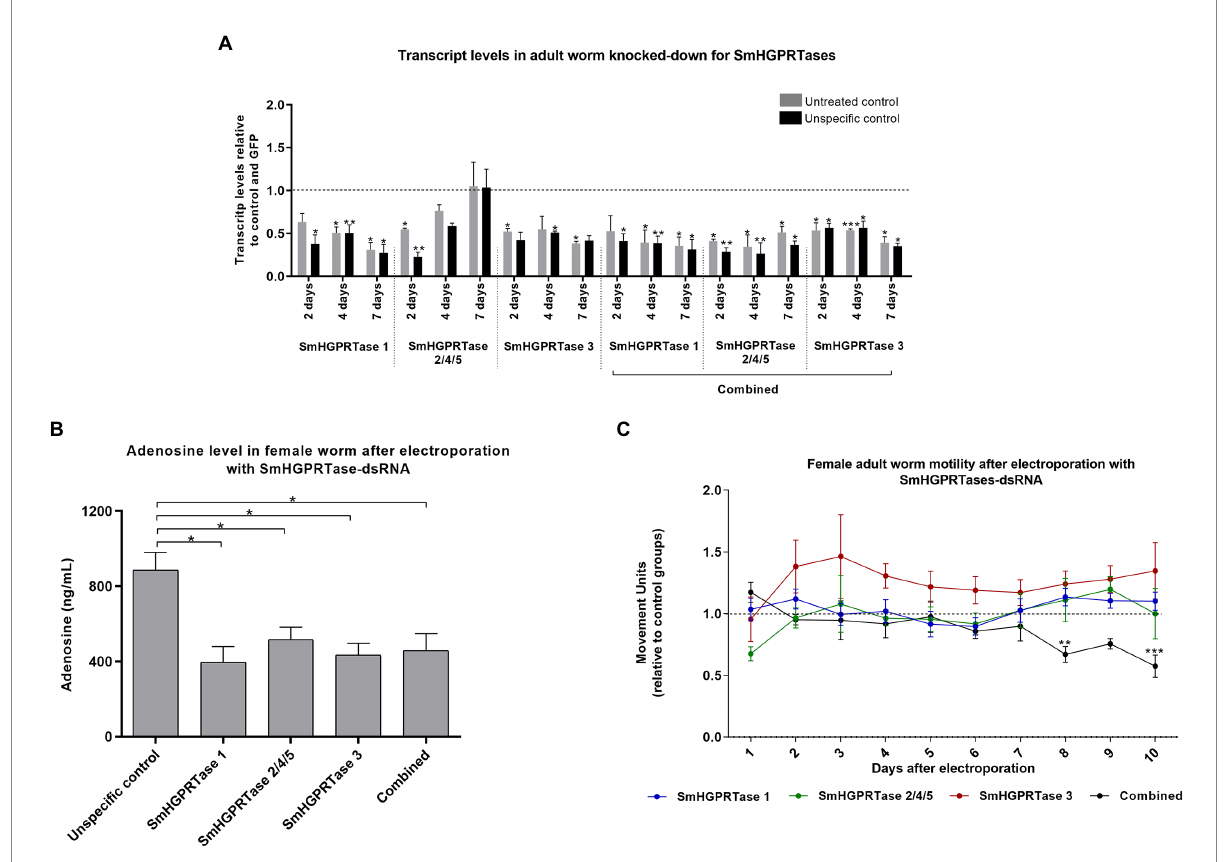
FIGURE 8 SmHGPRTases transcript levels after adult worm electroporation with dsRNAs and knockdown effects in adenosine levels and motility. (A) Bars representing the transcript levels of SmHGPRTase 1, SmHGPRTase 2/4/5, and SmHGPRTase 3 in adult worms after electroporation with specific dsRNAs separately or in combination (combined) relative to the untreated (gray) or unspecific control (GFP; black) after 2, 4, and 7 days. Above the bars are represented the standard error of the mean of three replicates. After verifying the normality using the Shapiro–Wilk test, significant differences compared to control conditions were analyzed by unpaired t -test. (B) Bars representing the adenosine levels in female adult worms in the respective groups: unspecific control, parasites exposed to SmHGPRTase 1 -dsRNA, SmHGPRTase 2/4/5 -dsRNA, SmHGPRTase 3 -dsRNA, and the combined group. Above the bars are represented the standard error of the mean of three replicates. After verifying the normality using the Shapiro–Wilk test, significant differences compared to control conditions were analyzed by unpaired t -test. (C) Motility of female adult worms exposed to SmHGPRTases -dsRNAs. Dots represent the average of the movement units of female adult worms that were electroporated with SmHGPRTases -dsRNAs. Blue, parasites exposed to SmHGPRTase 1 -dsRNA; Green, parasites exposed to SmHGPRTase 2/4/5 -dsRNA; Red, parasites exposed to SmHGPRTase 3-dsRNA; Black, parasites exposed to the combination of the three SmHGPRTases -dsRNAs. The results were normalized according to the movement units of female adult worms from controls (dotted line). Standard errors of the mean of three biological replicates are represented above the dots. Statistical analysis was performed using Two-way ANOVA followed by the Sidak post-test (* p ≤ 0.05; ** p ≤ 0.01; *** p ≤